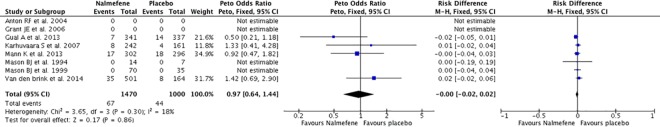
Serious adverse events of nalmefene compared to placebo in patients with substance use or/and impulse control disorder.